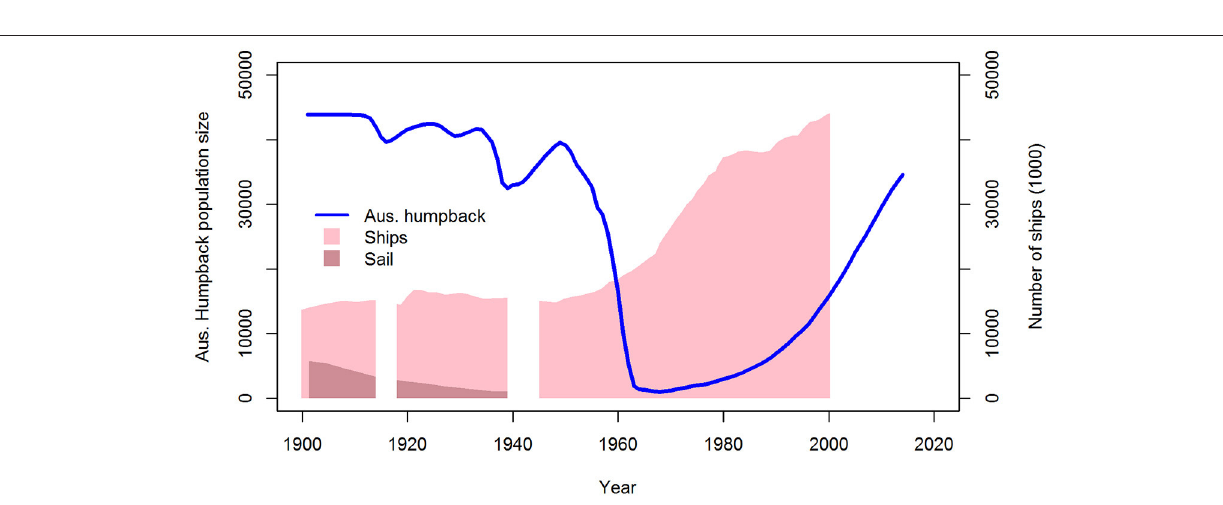
Vessels Involved in Whale